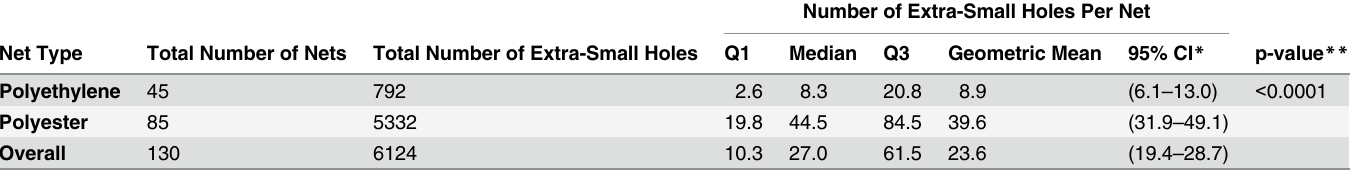
Table 4. Characteristics of nets with extra-small holes ( < 0.5 cm diameter) for 130 nets in the third year 2011.